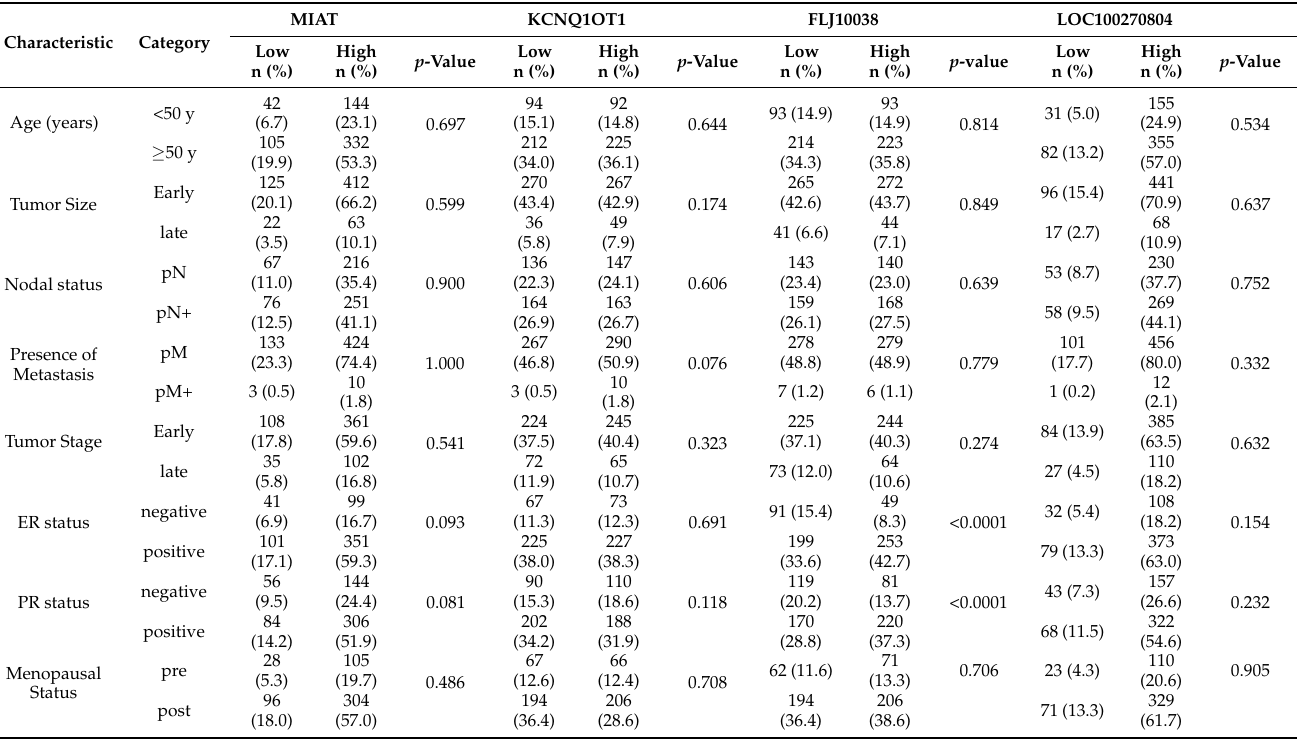
Table 1. Association of lncRNA expression with clinicopathological characteristics of primary ductal infiltrative breast cancer patients (Cbio Portal—TCGA